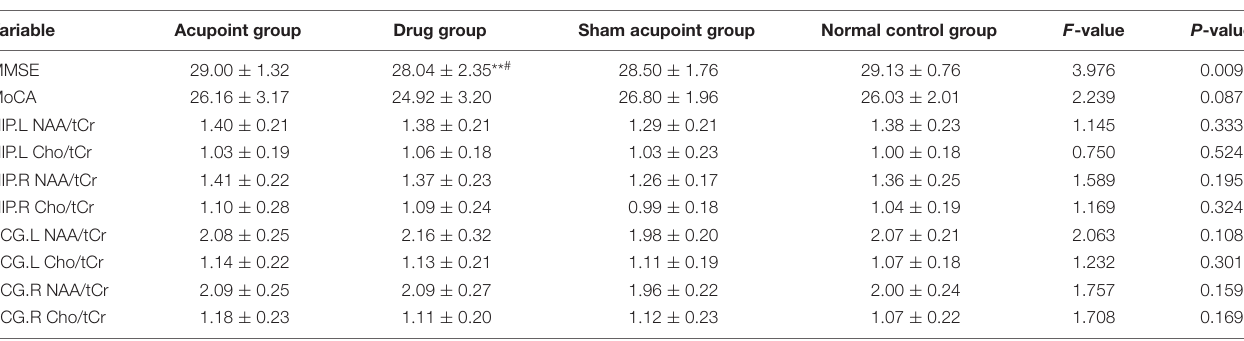
TABLE 3 | Cognitive scores and MRS results after treatment.